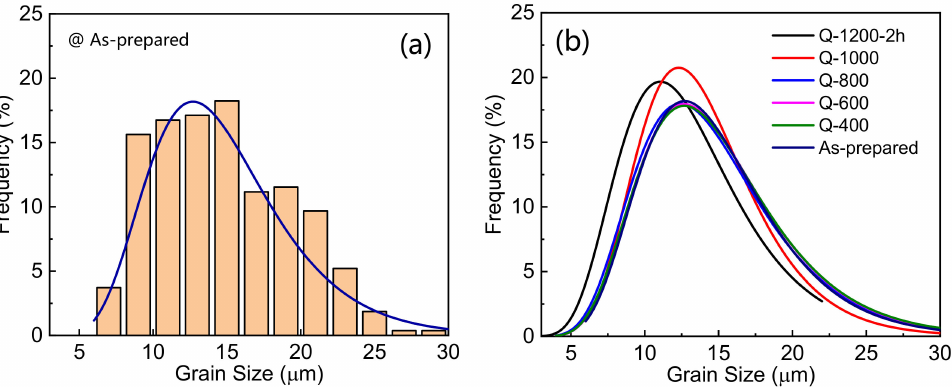
Figure 3. Statistic results of grain size distribution of the as-prepared ZnO ceramic sample ( a ) and fitting curves of grain size distribution of all the samples based on long-normal distributions ( b